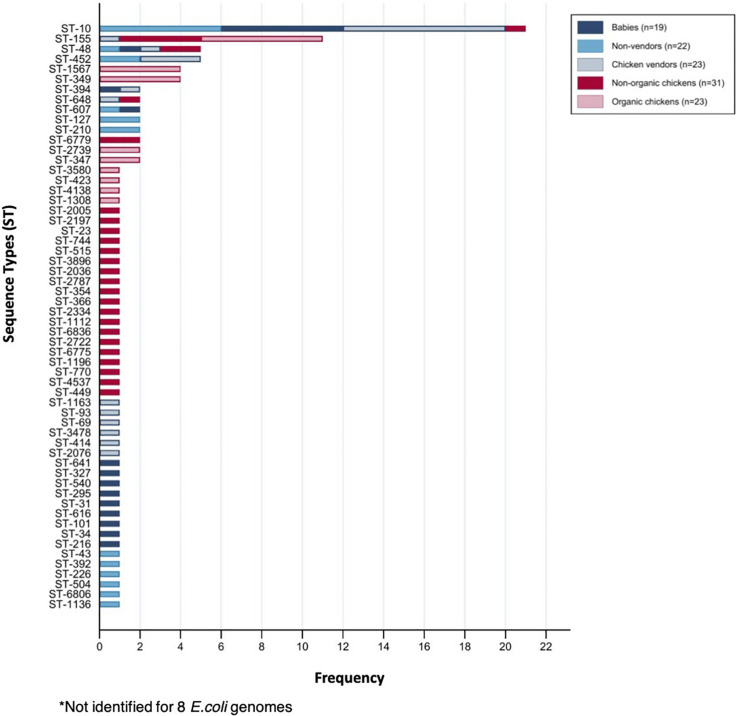
Sequence types (ST) identified among sequenced E. coli isolates.